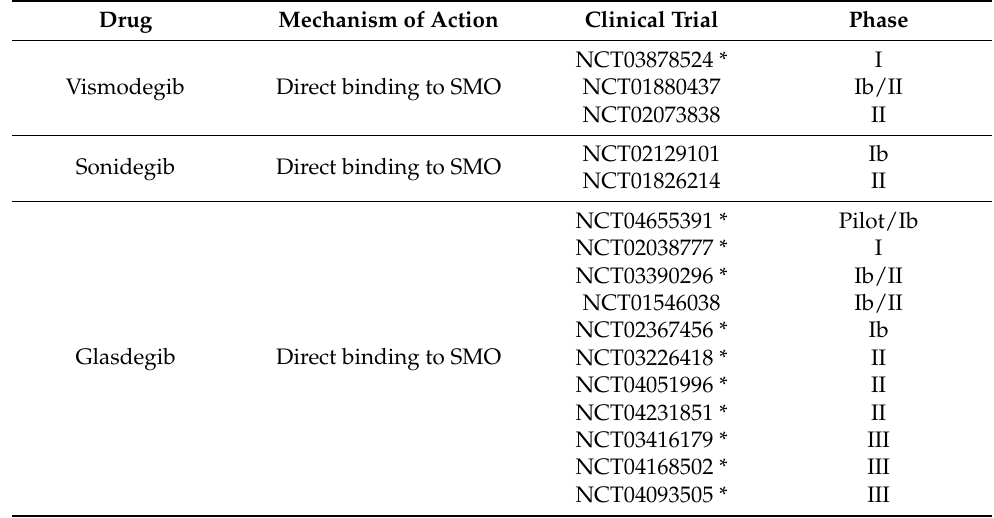
Table 1. Clinical trial based on the inhibition of Hedgehog in acute myeloid leukemia.